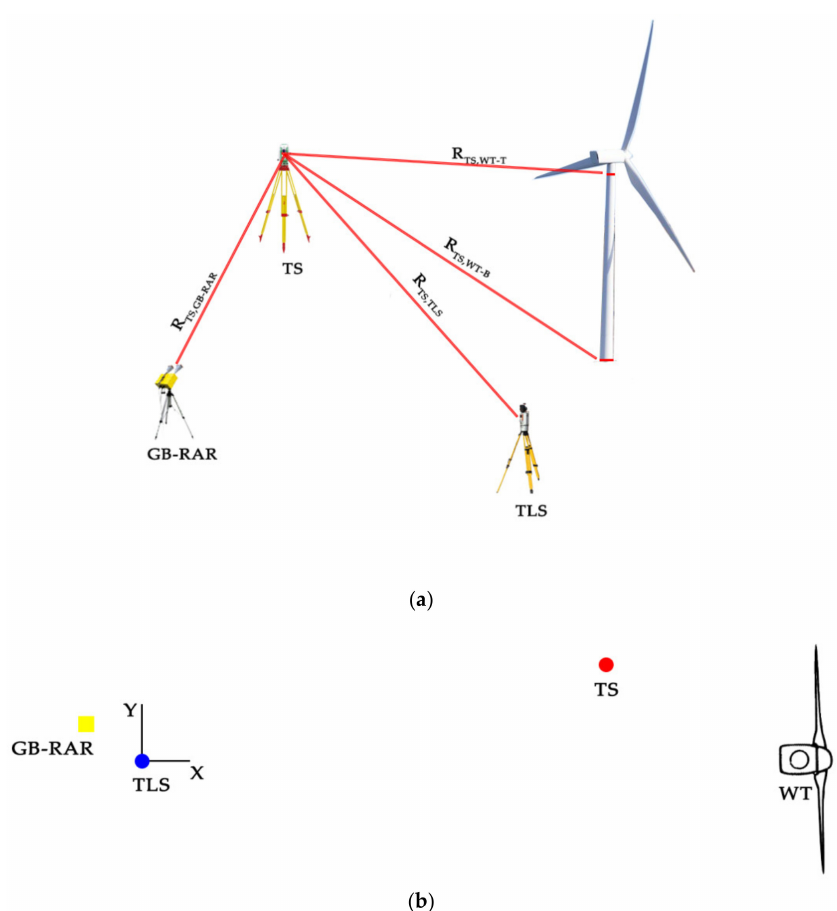
Figure 2. The TS survey layout with slant distances of TLS, GB-RAR, top and bottom of wind tower ( a ); The local reference system (TLS centered) used to co-locate TLS and GB-RAR measurements ( b ).